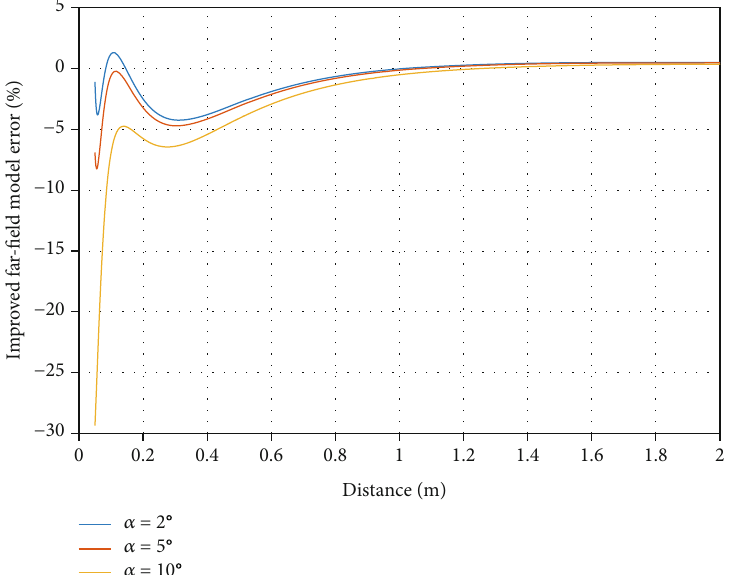
Figure 6: The percent error of the improved far- fi eld model ( α ≠ 0